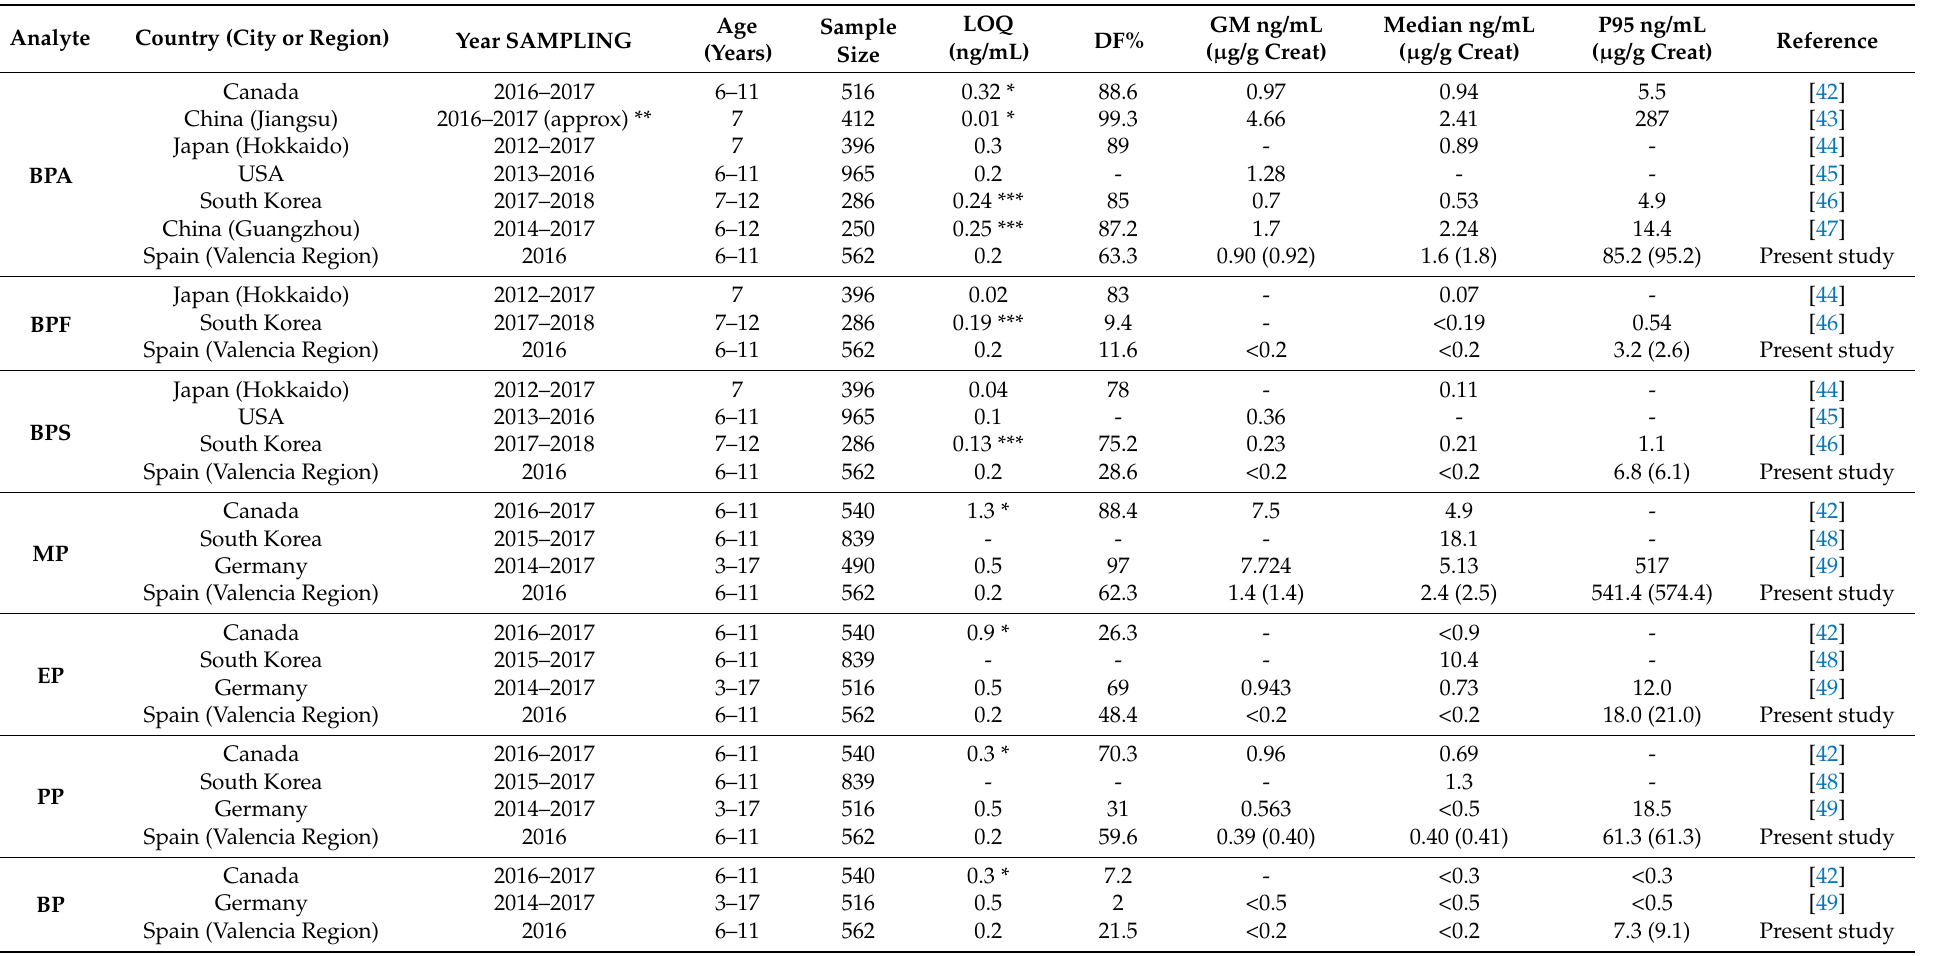
Table 5. Urinary levels of bisphenols, parabens and phthalates in children in large studies ( n > 200) with samples collected since